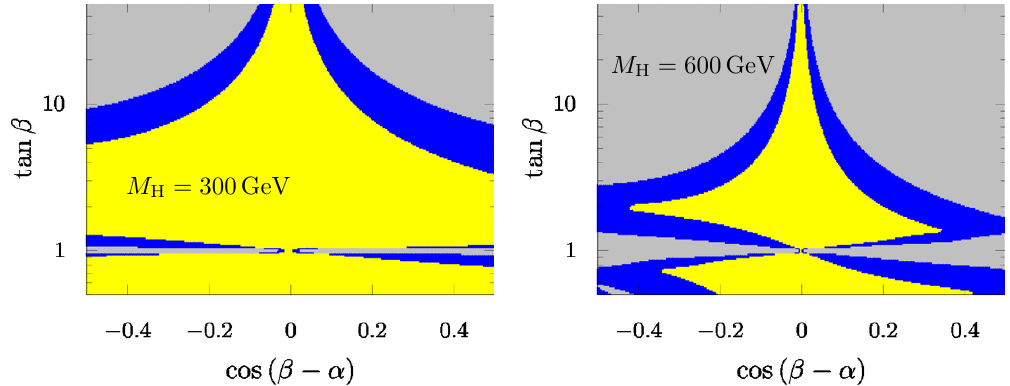
Figure 6 . The perturbativity measure for the scenario of (cid:12)gure 4. Gray areas are ruled out, while the blue and yellow areas show the maximal Higgs self-coupling strengths (cid:21)= (4 (cid:25) ) between 0.5 and 1, and 0.3 and 0.5, respectively. Parameter sets with values smaller than 0.3 do not occur.